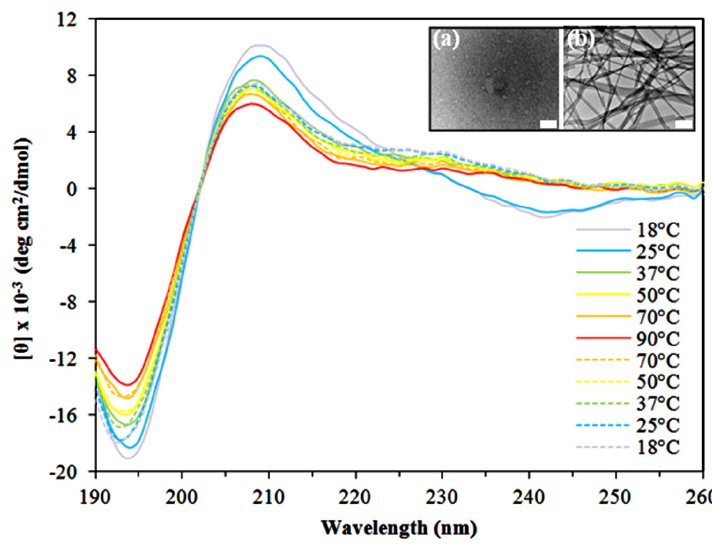
Figure 5. Temperature-dependent CD of 0.15 mM Asp-DOPA-Asn-Lys-DOPA in water. The temperature was increased in a stepwise fashion from 18 to 90 °C then similarly decreased to 18 °C. Insets show TEM micrographs of the CD cuvette content at ( a ) the end of the experiment and of ( b ) a control solution incubated at room temperature. Negative staining was not applied. Scale bars of the insets represent 200